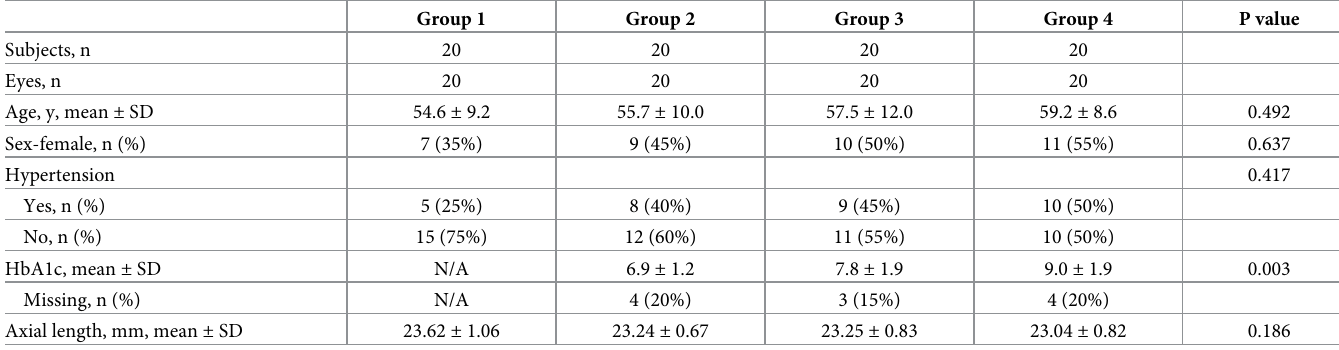
Table 1. Demographic and clinical characteristics of study